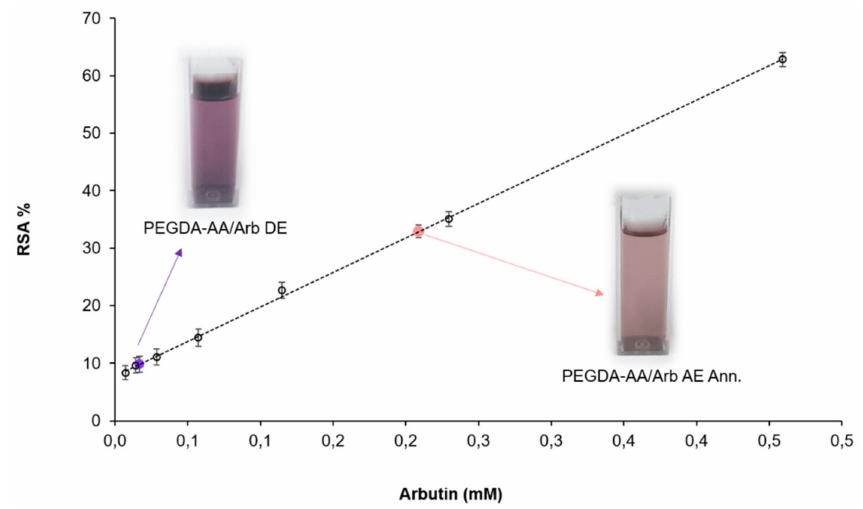
Figure 6. DPPH assay to assess in vitro antioxidant activity. The calibration curve (r 2 0.999) was obtained with arbutin-containing solutions at decreasing concentrations (from 0.5 mM to 8 µ M). The cuvettes refer to PEGDA-AA / Arb DE and PEGDA-AA / Arb AE